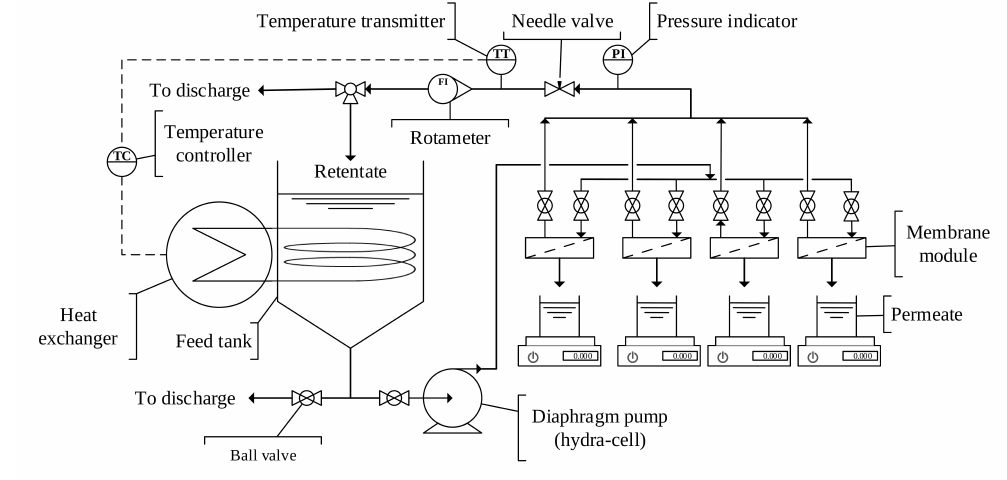
Figure 1. A schematic diagram of cross-flow laboratory-scale filtration